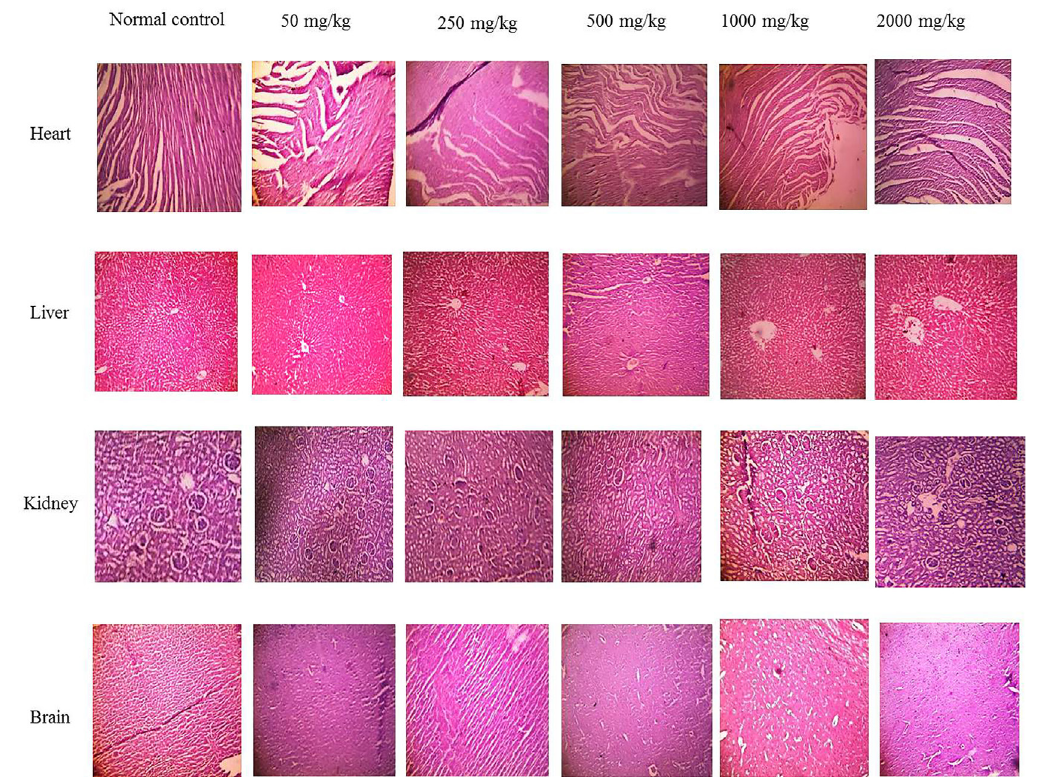
FIGURE 3 - Histopathology (H&E stain10x) of rat tissues of treated groups rats after 28th